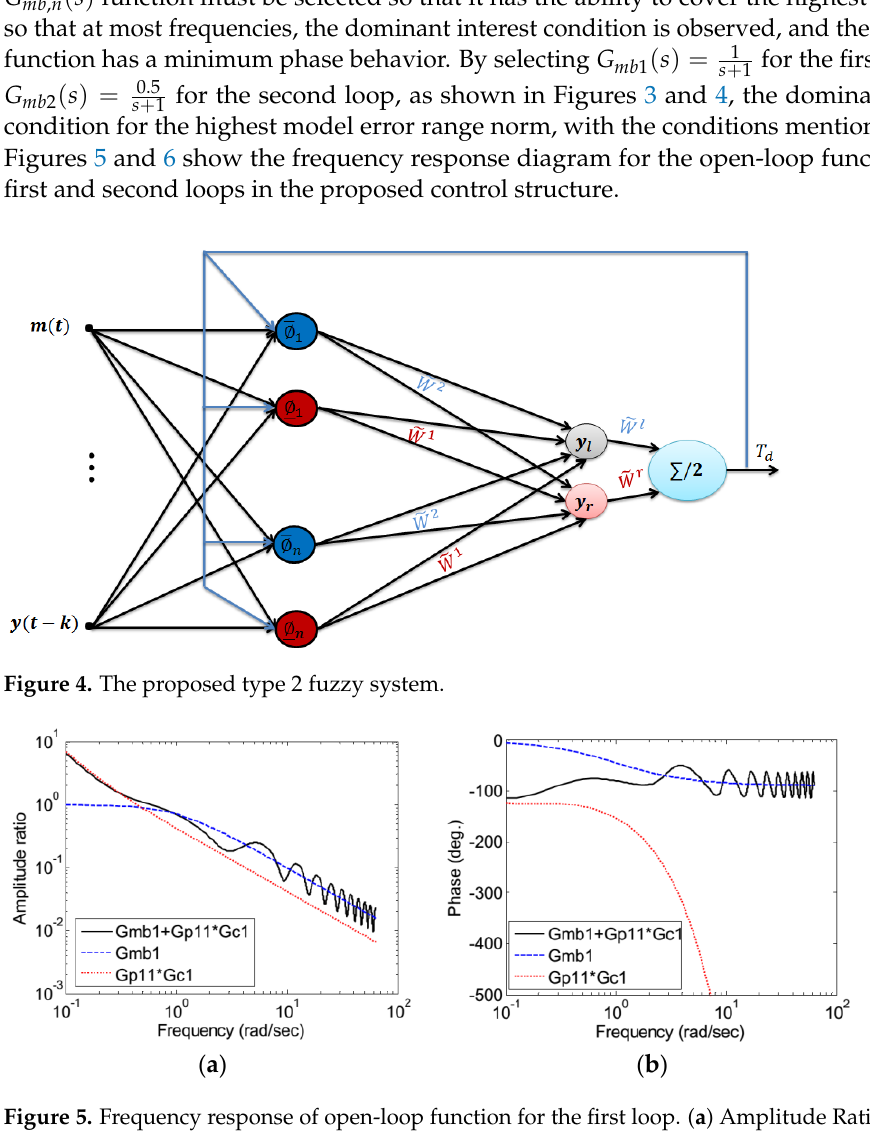
( b ) Figure 6. Frequency response of open-loop function for the second loop. (a) Amplitude Ratio (b) Phase As can be seen in these figures, the condition for the superiority of the G mb,n (s) gain in most frequencies is such that the phase diagram is limited before reaching the − 180° point in these two loops. Therefore, it can be concluded that the selection of G mb,ii (s) is appropriate in both loops. Additionally, the minimum phase behavior of the open-loop function in the proposed method is one of the advantages of this method compared to the methods in which the open-loop function of the control system has non-minimum phase behavior. Figures 7 – 10 show the performance of Smith ’s predictive control systems, Smith ’s predictor with dominant gain, and the proposed control system (Smith ’s predictor with dominant gain and type-2 fuzzy estimator for time delay). In this example, y 1 is dis- tillate composition, y 2 is bottom composition, and u is reflux flow rate. It should be noted that the reference for y 1 is the step signal with the step time t = 50 s, and for y 2 , this is the step with the step time t = 200 s. The control signals u 1 and u 2 are shown in Figures 8 and 9, respectively.